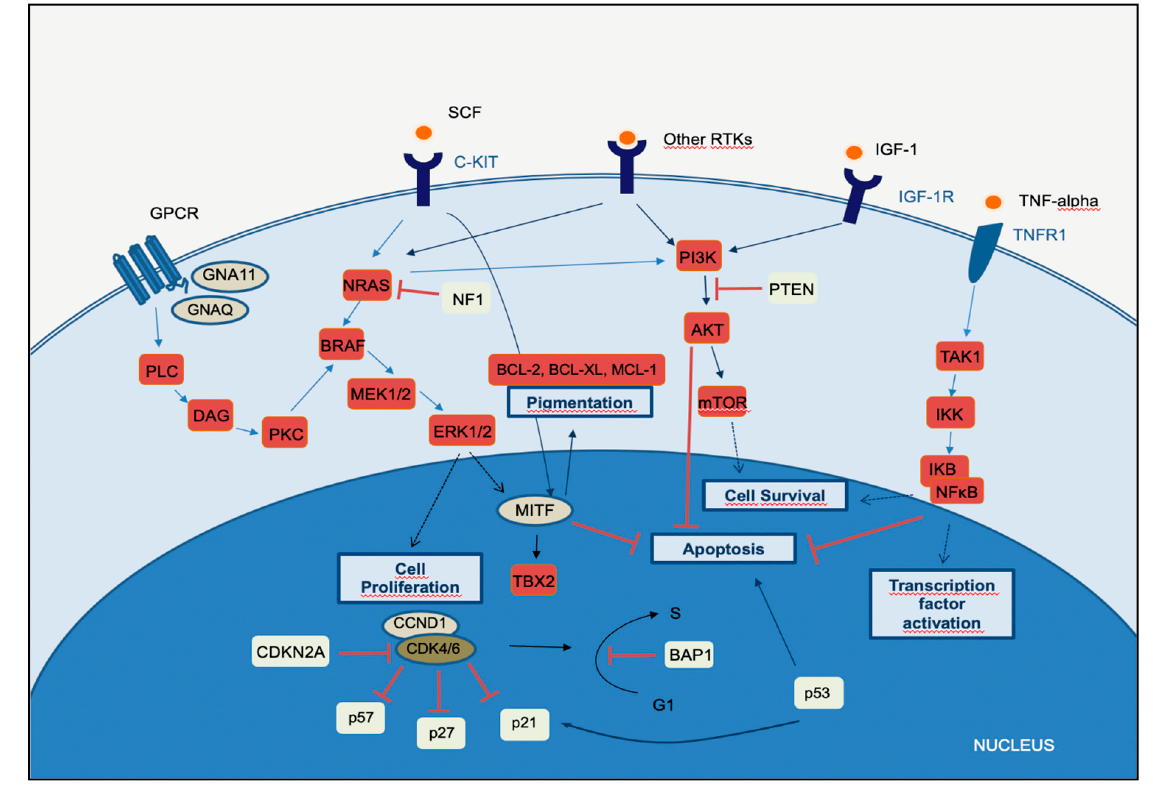
Figure 1. Melanoma key signaling pathways.